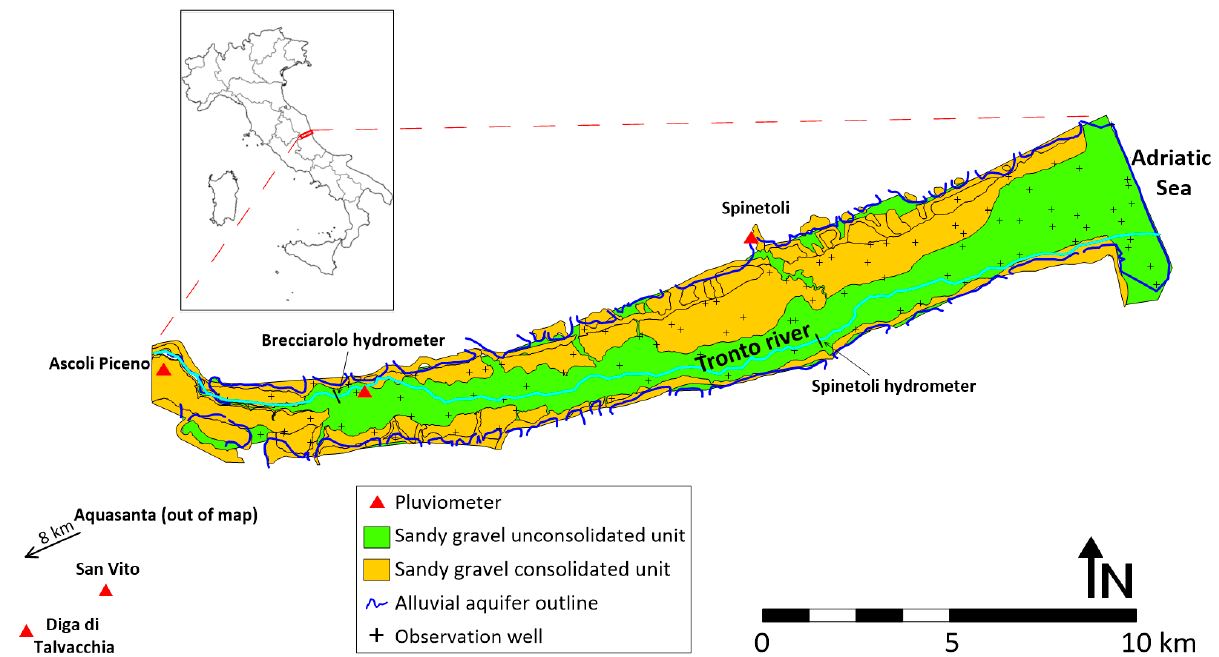
Figure 1. Hydrogeological setting of the Tronto alluvial aquifer.